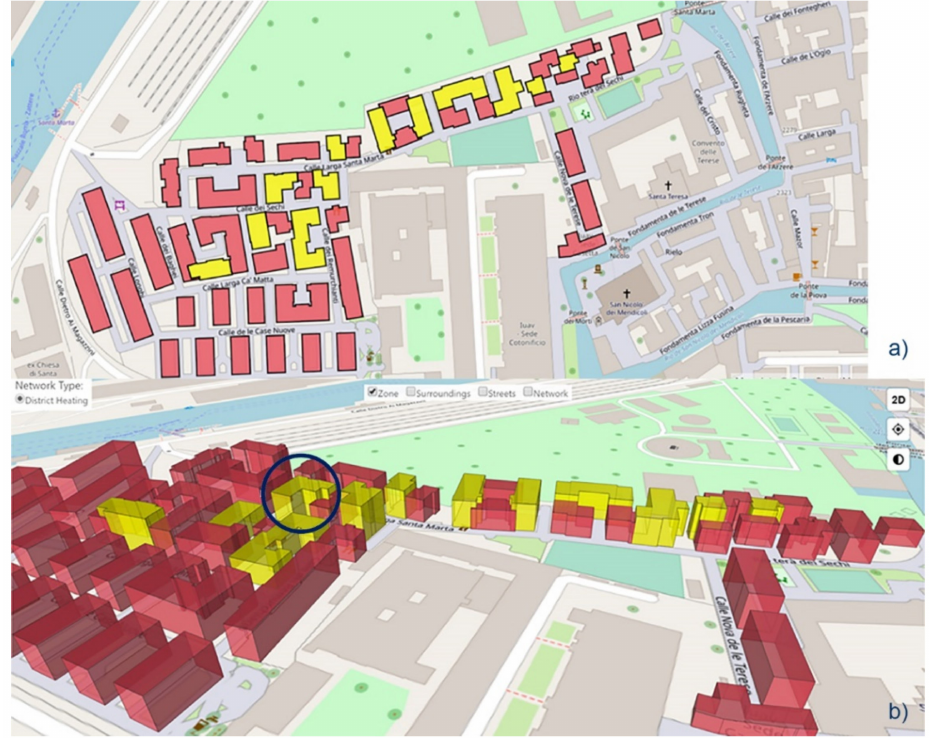
Figure 6. Geometric and thermal modeling of the building in the case study: ( a ) plant view, high- lighted in yellow are the buildings presenting different heights within the same unit; ( b ) 3D view, focus on a sample building in case of contiguity and difference of